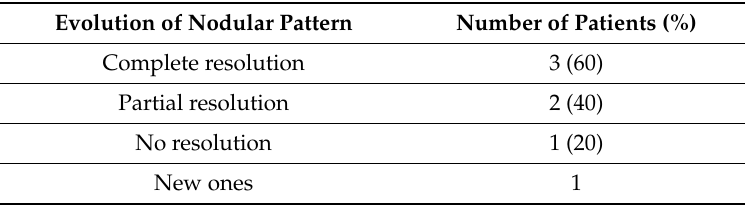
Figure 12. On the left ( a ): baseline HRCT. On the right ( b ): follow-up HRCT; a new nodule (arrowhead) appeared in the left lower lobe. Table 7. Evolution of the 5 patients with a nodular pattern.